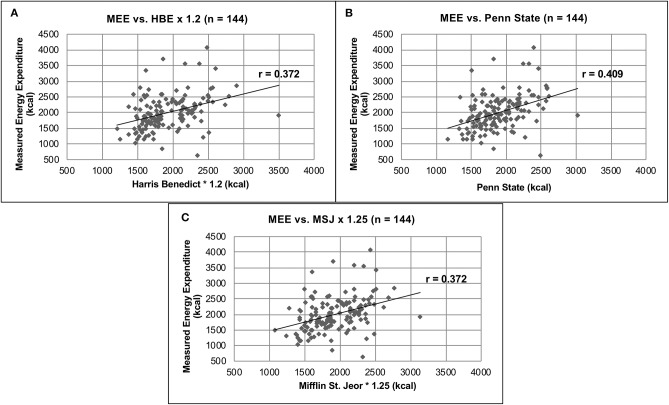
Comparison of MEE vs. PEE. (A) MEE vs. HBE × 1.2 (n = 144). (B) MEE vs. Penn State (n = 144). (C) MEE vs. MSJ × 1.25 (n = 144).